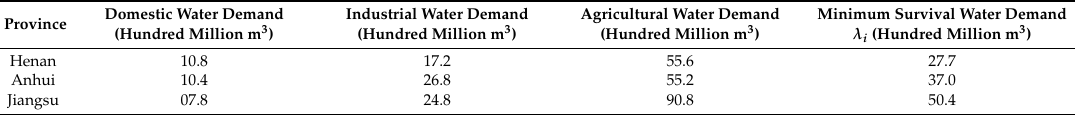
Table 3. The minimum survival water demand λ i (hundred million m 3 ) of each province.